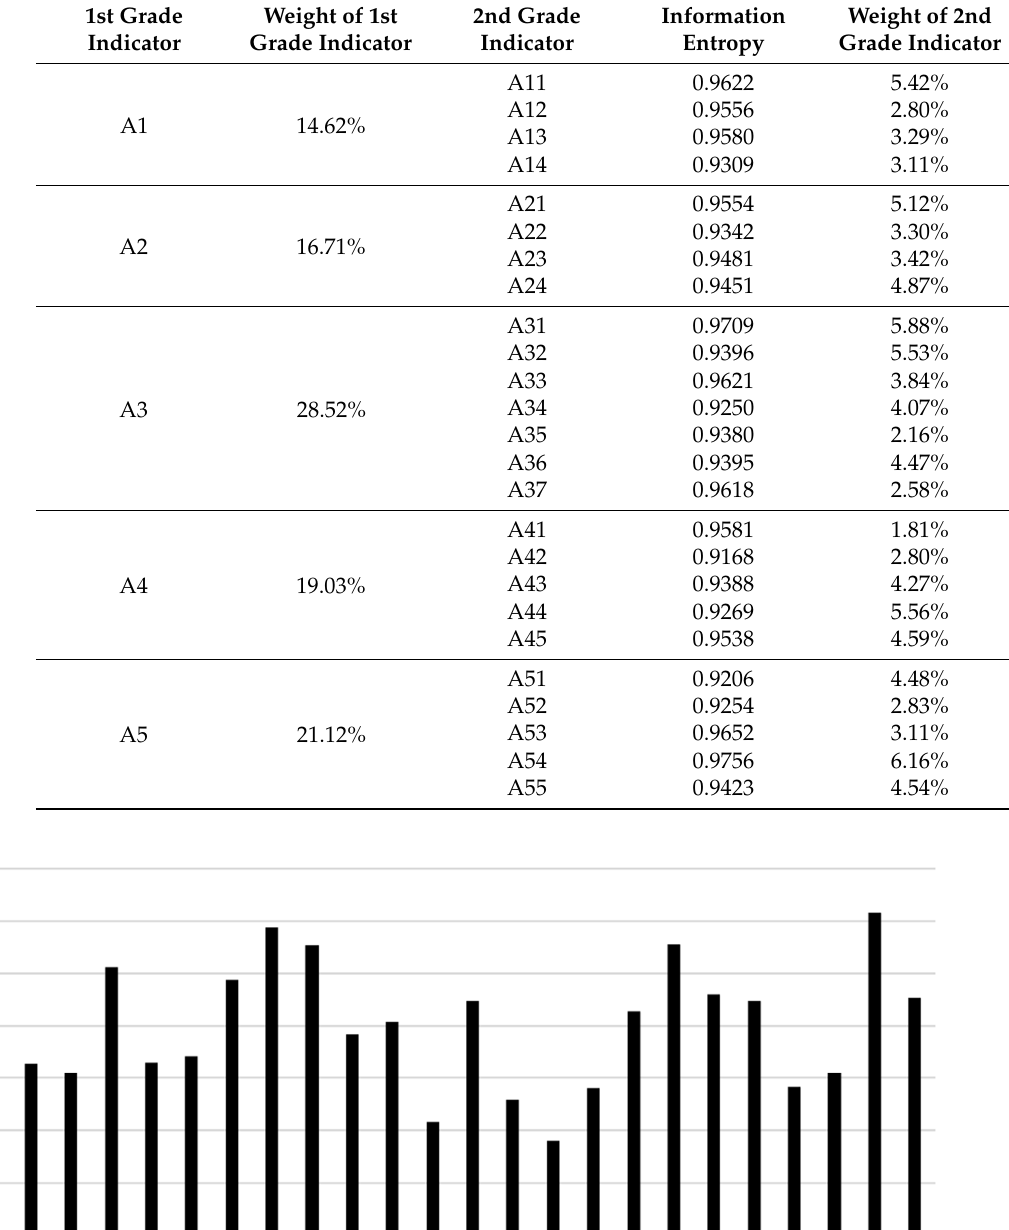
Table 3. Information entropies and weights of all evaluation indicators of food security.